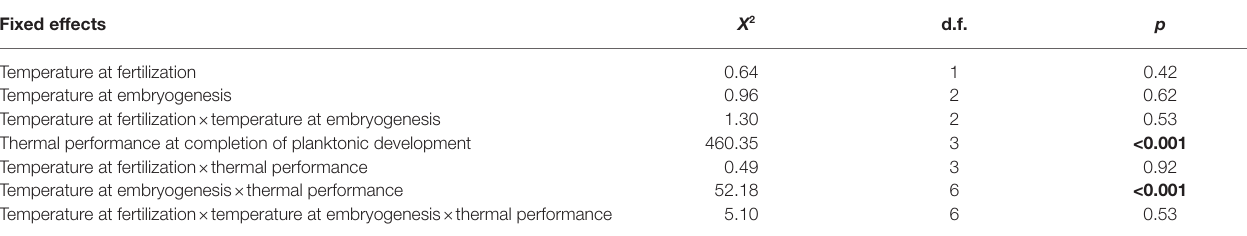
TABLE 1 | Effects of prior temperatures at fertilization and embryogenesis on thermal performance in terms of survival at completion of planktonic development (modeled as a cubic function of temperature in a binomial mixed-effects regression